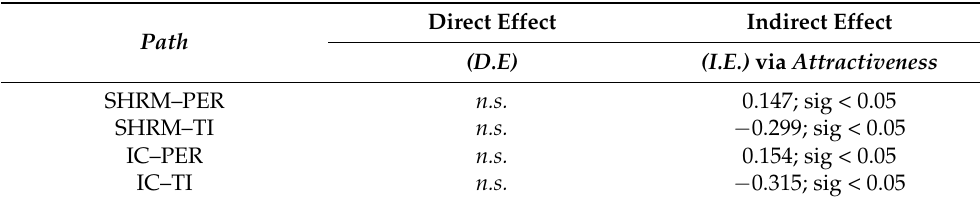
Table 2. Theoretical model’s standardized direct and indirect